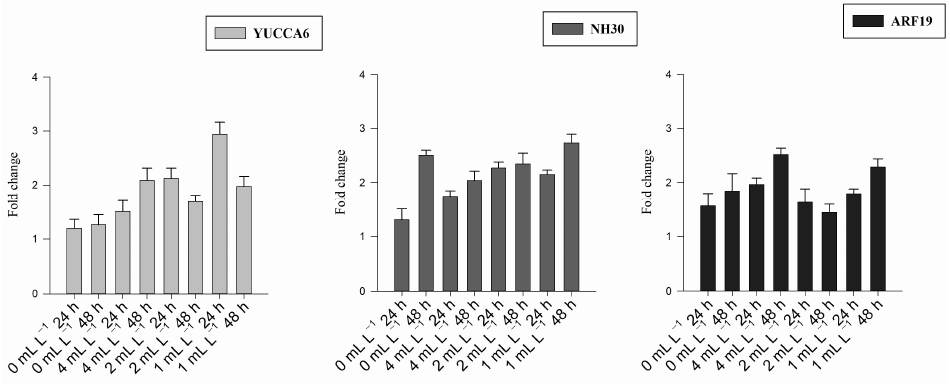
Figure 2. Fold change for the gene expression analysis of the auxin-related genes 24 and 48 h after treatment for all the BSE concentrations (0 mL L −1 : untreated; 4 mL L −1 ; 2 mL L −1 ; 1 mL L −1 ). Each bar-plot shows the mean of eight replicates with the standard error of the mean.